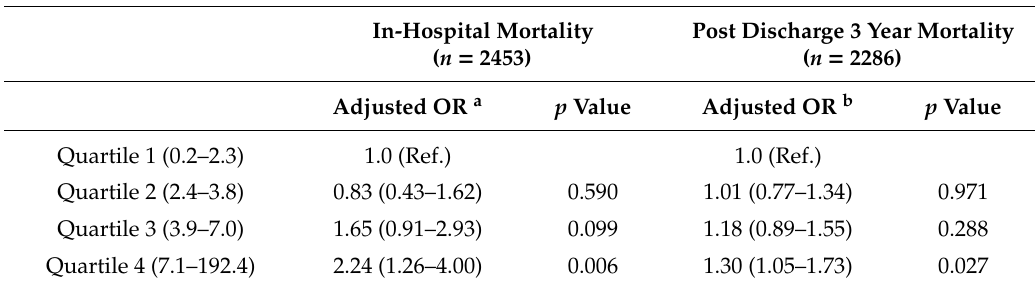
Data are expressed as odds ratio (OR) and 95% confidence intervals (CI). Ref. = reference category. a adjusted for age category (70 > vs. 70 ≤ ), sex (male vs. female), body mass index category (25 > vs. 23 ≤ ), etiology of heart failure (ischemic vs. non-ischemic), systolic blood pressure (100 > vs. 100 ≤ ), history of hypertension, history of diabetes mellitus, history of cerebrovascular disease, history of chronic obstructive disease, prior admission history due to HF, presented tachyarrhythmia on admission, sodium level (135 > vs. 135 ≤ ), creatinine level (2.0 > vs. 2.0 ≤ ), left ventricular ejection fraction (HFrEF vs. HFmrEF vs. HFpEF), BNP ≥ 500 pg / mL or NT-proBNP ≥ 1500 pg / mL. b adjusted for age category (70 > vs. 70 ≤ ), sex (male vs. female), body mass index category (23 > vs. 23 ≤ ), etiology of heart failure (ischemic vs. non-ischemic), systolic blood pressure (100 > vs. 100 ≤ ), history of hypertension, history of diabetes mellitus, history of cerebrovascular disease, history of chronic obstructive disease, prior admission history due to HF, presented tachyarrhythmia on admission, sodium level (135 > vs. 135 ≤ ), creatinine level (2.0 > vs. 2.0 ≤ ), left ventricular ejection fraction (HFrEF vs. HFmrEF vs. HFpEF), BNP ≥ 500 pg / mL or NT-proBNP ≥ 1500 pg / mL, AA, BB,